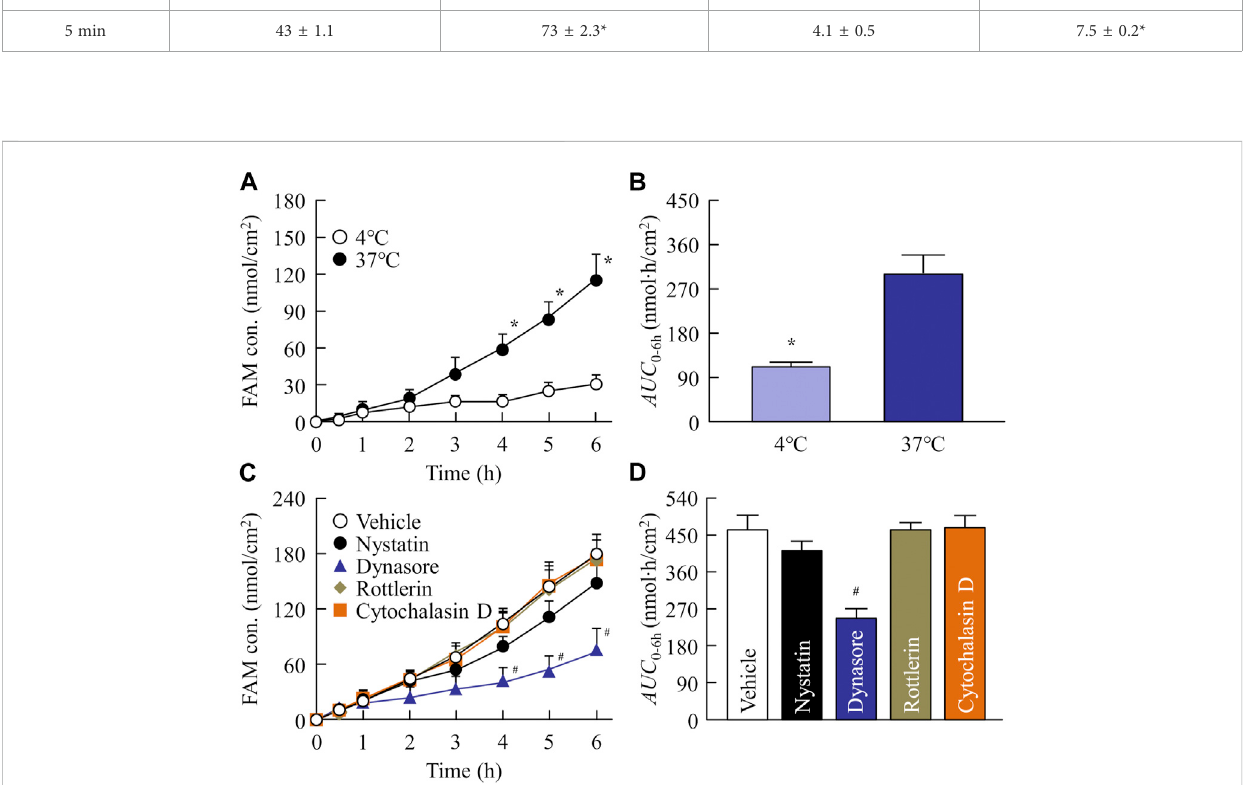
FIGURE 5 Evaluation of transintestinal penetration of drug using rat intestines co-treated with FAM-NP tablet (Rp.9 formulations) and endocytosis inhibitors. Penetration pro fi le (A) and AUC 0 – 6h (B) of FAM in the FAM-NP tablet under cold (4 ° C) and normal (37 ° C) conditions. Penetration pro fi le (C) and AUC 0 – 6h (D) ofFAM in therat intestines co-treated with FAM-NP tablet and endocytosis inhibitors [vehicle (0.5% DMSO), nystatin,dynasore, rottlerin, cytochalasin D]. n = 6 – 9. * p < 0.05 ° C vs. 37 ° C for each category. # p < 0.05 vs. the vehicle for each category. The intestinal penetration of the FAM-NP tablet was attenuated by the inhibitor of clathrin-mediated endocytosis,